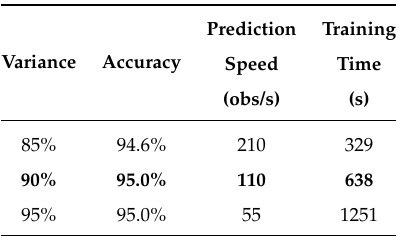
Table 6. Prediction speed and training time results for the best performance classifiers of each variance (85%, 90% and 95%) using the k -NN classification method on a 3GHz Intel Core i7, 16 GB RAM computer. The best classifier in terms of accuracy is highlighted using a boldface font.